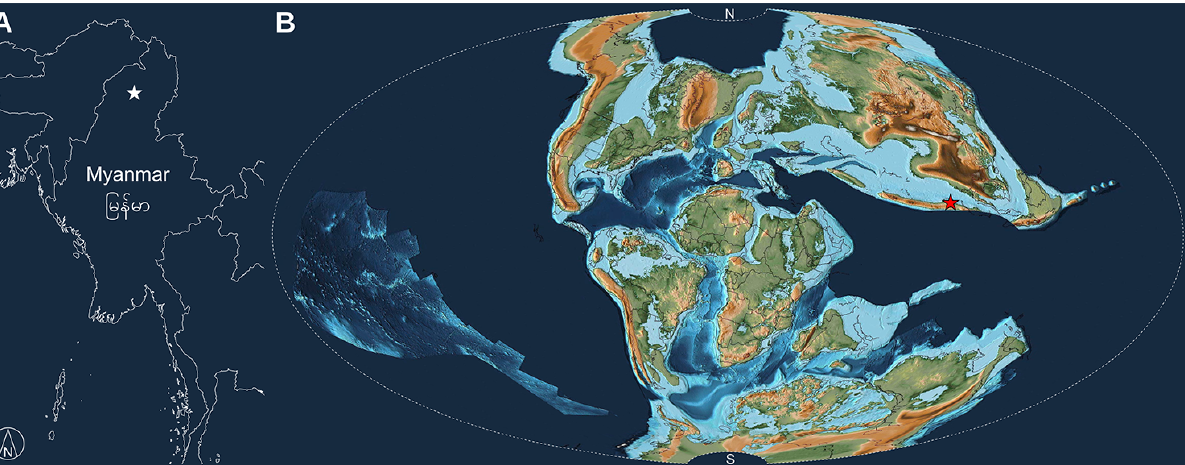
Figure 1. A: Map of Myanmar, white star marks the location of the Burmese amber mining sites near the town Noje Bum, base map from OpenStreetMap (openstreetmap.org); B : palaeogeographic world map, Aitov projection, 100 million years in the past, base image from PALEOMAP project (Scotese, 2016), red star marks the location of the Burmese amber